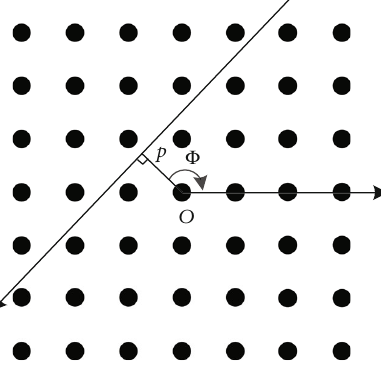
Figure 3: De fi nition of the trace